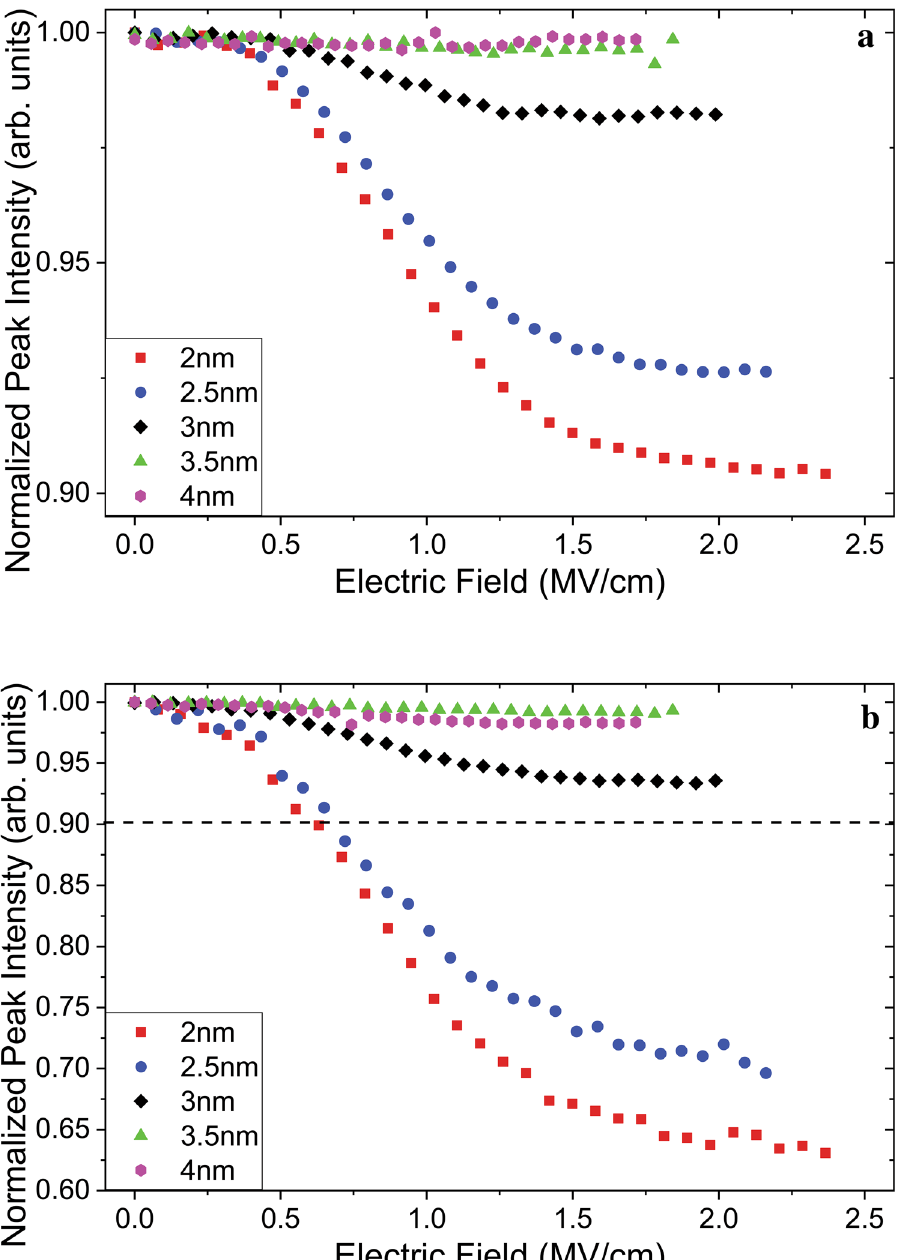
Figure 5. Integrated PL intensities plotted against the electric field for samples with varied inter-layer-oxide barrier thicknesses of the passivated ( a ) and non-passivated ( b ) sample sets, measured at RT. The dashed line in ( b ) marks the lower limit of the vertical axis in ( a